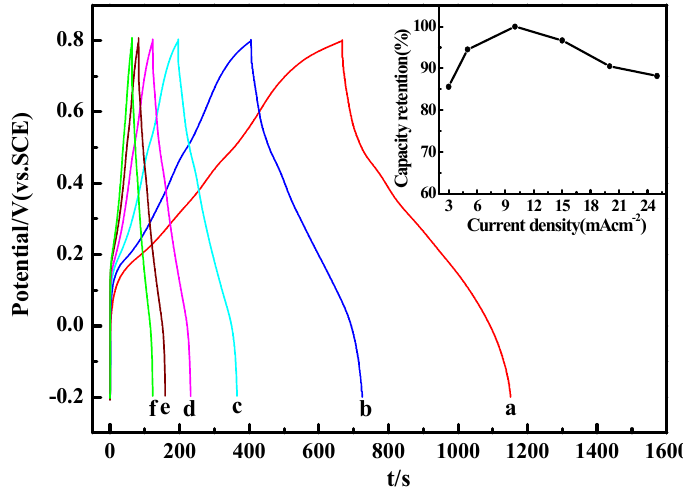
Figure 6. Charge-discharge curves of PANI-0.5 at different current densities in 1 M H electrolyte: ( a ) 3 mA . cm − 2 ; ( b ) 5 mA . cm − 2 ; ( c ) 10 mA . cm − 2 ; ( d ) 15 mA . cm − 2 ; ( e ) 20 mA . cm − 2 ; ( f ) 25 mA . cm − 2 . The inset shows the capacity retention as a function of current